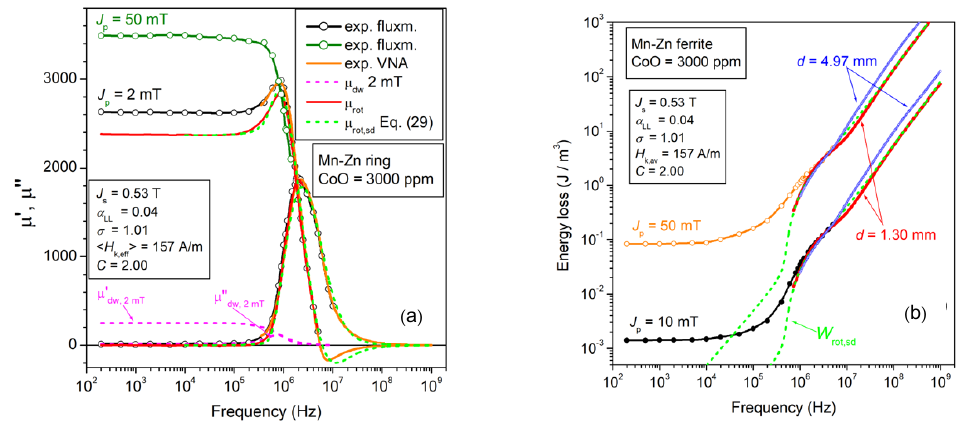
Figure 6. ( a ) The rotational permeability components μ ′ rot ( f ) and μ ″ rot ( f ) are singled out in a CoO- doped Mn-Zn ferrite ring sample, following the scheme provided by Equations (19)–(23). The symbols and the solid lines are the results of fluxmetric (exp. fluxm.) and transmission line (exp. VNA) measurements. They are theoretically calculated using Equations (29a) and (29b) (dashed lines) with lognormal distribution function for the effective anisotropy field strength H k,eff (average value < H k,eff >). The parameters of the distribution, given in the inset, are the width σ and the constant C (Equations (27) and (31)). α LL is the Landau–Lifshitz damping constant. ( b ) The corresponding rotational loss by spin damping W rot,sd ( f ) is obtained from the calculated rotational permeabilities by means of Equation (13). The additional contribution by eddy currents is observed beyond a few MHz in the thicker sample ( d = 4.97